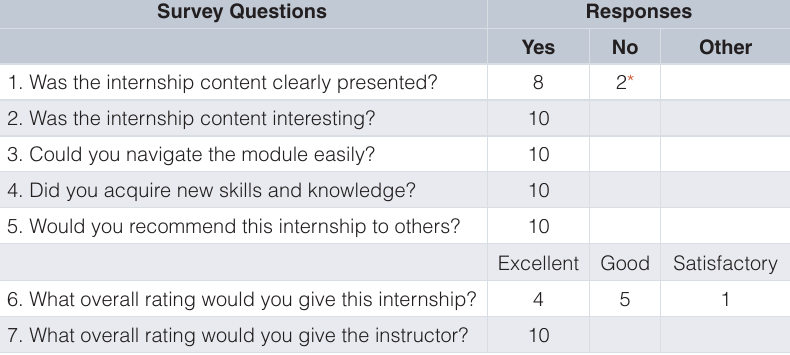
Table 2. Neuroinformatics Internship Student Survey 2016.